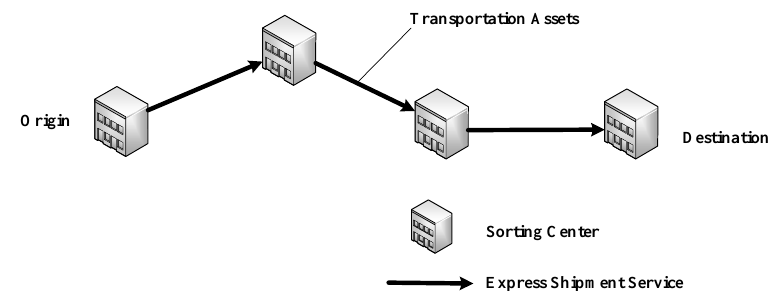
Figure 1. Express service